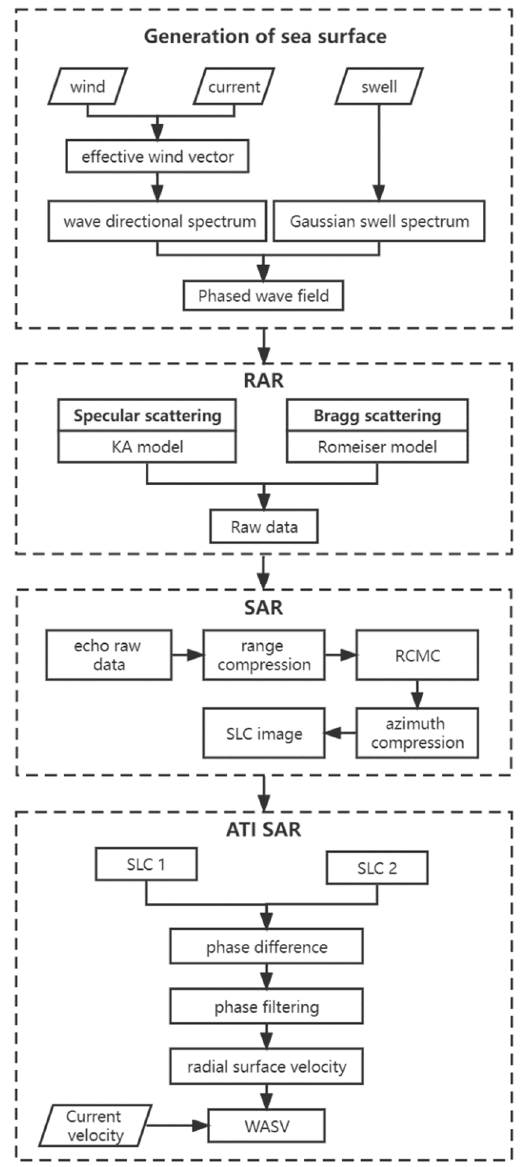
Figure 1. The different phases of the study.